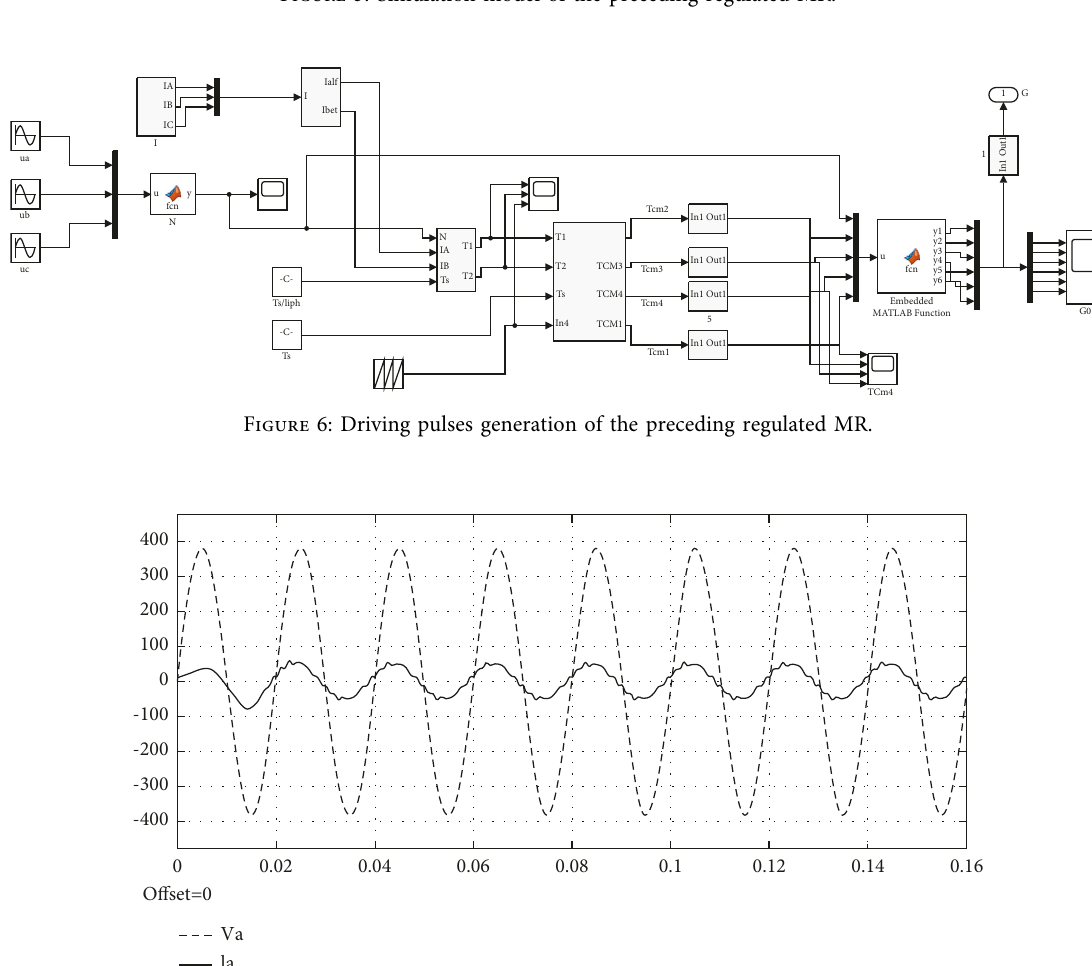
Figure 5: Simulation model of the preceding regulated